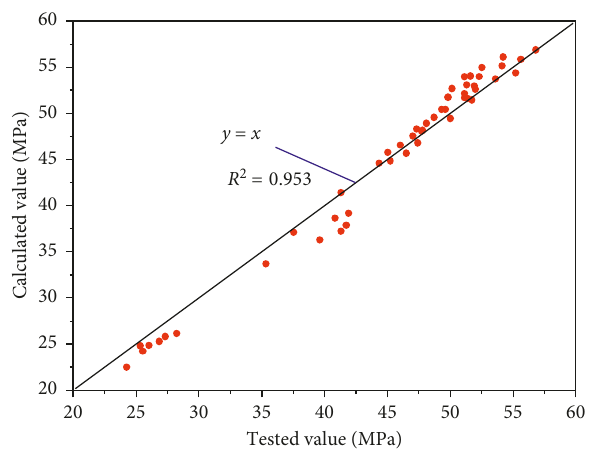
Figure 15: Comparison of calculated values and tested values of ( t ) . ASC’s f cu